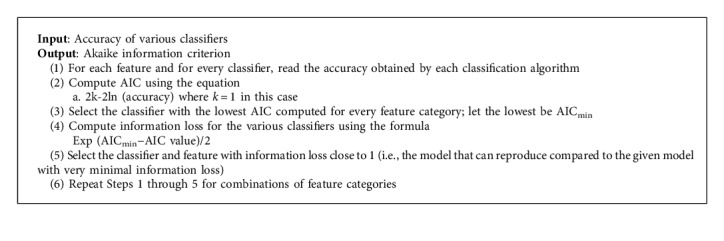
AIC computation.